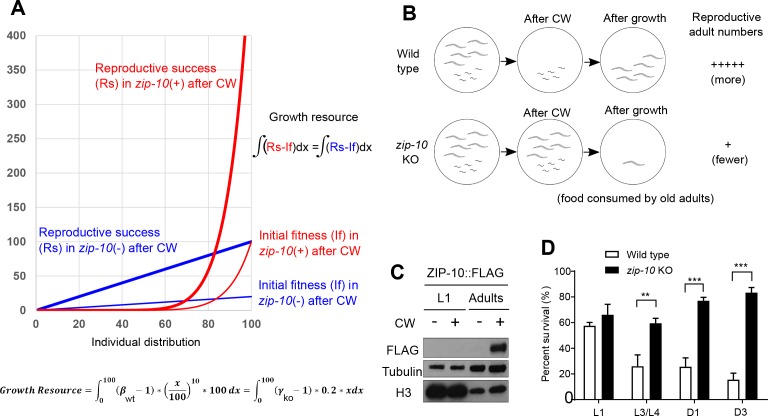
ZIP-10 constitutes a genetic program promoting kin selection of C. elegans under resource-limiting and stress conditions.(A) Mathematical model illustrating the advantage of wild-type (red line) versus zip-10 KO animals (blue line) at the population level under growth resource-liming and thermal stress conditions. Individual fitness distribution (x-axis) after cold-warming thermal stress is set to be exponential (thin red line) and linear (thin blue line) to fit the phenotypic differences in death rates of wild type and zip-10 KO animals and to simplify comparison and calculation. Given the same period of time and the same amount of growth resources (integral differences between thin and thick lines), wild-type population yields more thermal stress-adapted reproducing animals than zip-10 deficient animals. The parameters for integrals were adjusted so that the ‘growth resources’ are the same despite that the population growth modes are different for wild type and zip-10 KO. (B) Schematic illustrating an exemplar situation of the mathematical model in which five post-reproduction adults and five larvae are living in a food-limiting condition. After cold-warming thermal stress, wild-type adults die out, leaving food for young larvae to grow into reproductive adults whereas zip-10 KO post-reproduction adults do not die, consuming the limited food and competing out the young larvae so that fewer reproductively active zip-10 KO animals emerge from such conditions. (C) Experimental evidence indicating the specific induction of zip-10p::zip-10::EGFP::FLAG by CW as measured by western blot in adults but not in larvae. (D) Survival rates of wild type and zip-10 KO (ok3462) animals at different stages after prolonged CW thermal stresses (96 hrs cold shock for L1 while 48 hrs for others) showing that ZIP-10’s pro-death effects are more prominent in old animals. n ≥ 20 total animals for each group with N ≥ 3 independent biological replicates; *** indicates p<0.001, ** indicates p<0.01.